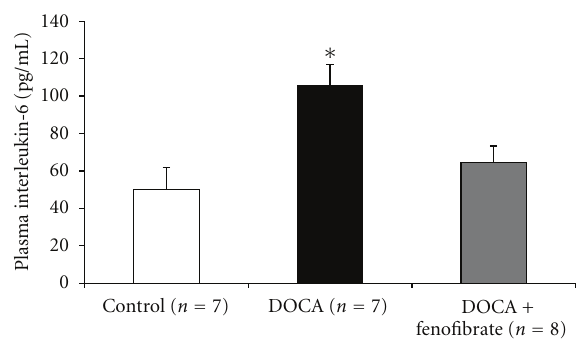
Figure 3: Plasma interleukin-6 on day seven of DOCA-salt hypertension in control, DOCA and DOCA + fenofibrate-treated mice ( ∗ indicates DOCA significantly increased plasma IL-6 when compared to control and DOCA + fenofibrate; P < 0 .